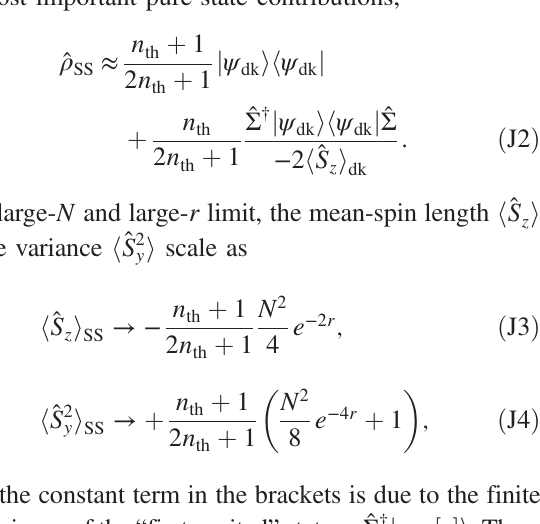
FIG. 16. Scaling of the optimal squeezing parameter r introduced in Sec. VI and of the steady-state purity if the engineered reservoir stabilizes an impure squeezed state [as modeled by Eq. (29)]. For each value of n determined by numerically minimizing ξ 2 with n . The dashed lines are fits to a power law n − 0 . 25 th (b) Scaling of e 2 r opt with N . The dashed lines are fits to a power law N 0 . 75